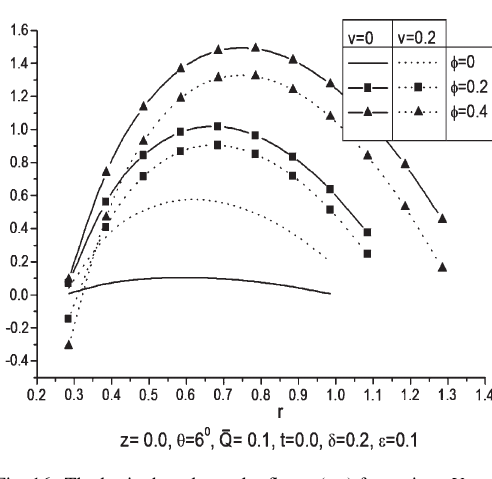
Fig. 16. The basic thread-annular flow u ( r,t ) for various V . the basic wq1flow will increase as the velocity of the inner tube increase for φ = 0 ( no peristaltic wave), but for φ / = 0 this effect is